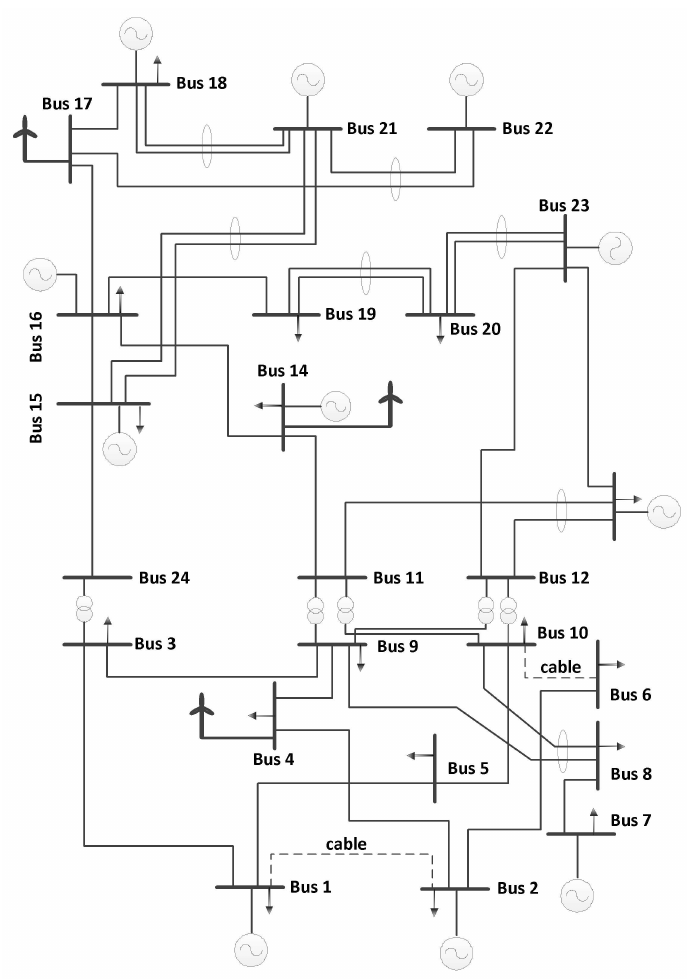
Figure 3. Modified IEEE reliability test system